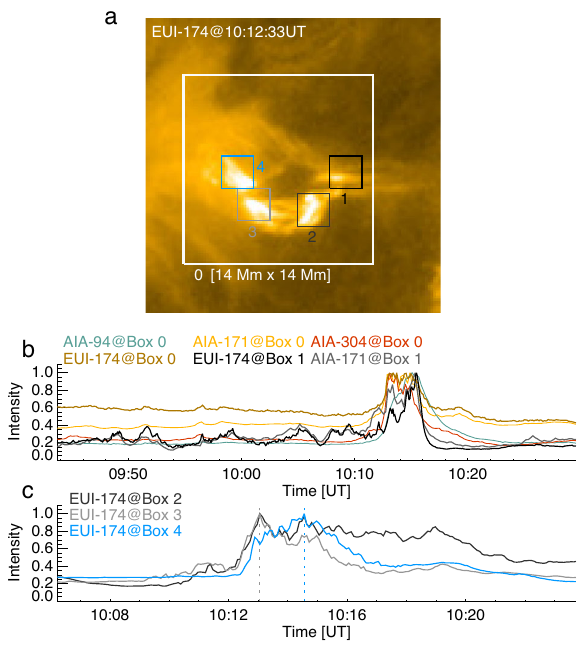
Fig. 5 | Light curves of null-point reconnection. a The EUI/HRI EUV 174 Å image at 10:12:33 UT showing the spiral jet caused by the erupting mini- fi lament. Box 0 covers the area of the whole null-point and fan-spine structure, whereas Box 2 – 4 outline three regions that brighten. b Temporal evolutions of the HRI EUV 174 Å (gold), AIA 94 Å (cyan),171 Å (yellow), 304 Å (red)integratedintensities withinBox 0 whose location is indicated in a . The HRI EUV 174 Å (black curve) and AIA 171 Å (grey curve) intensities within Box 1 are overplotted. c Temporal evolutions of the HRI EUV 174 Å integrated intensities within Box 2 –